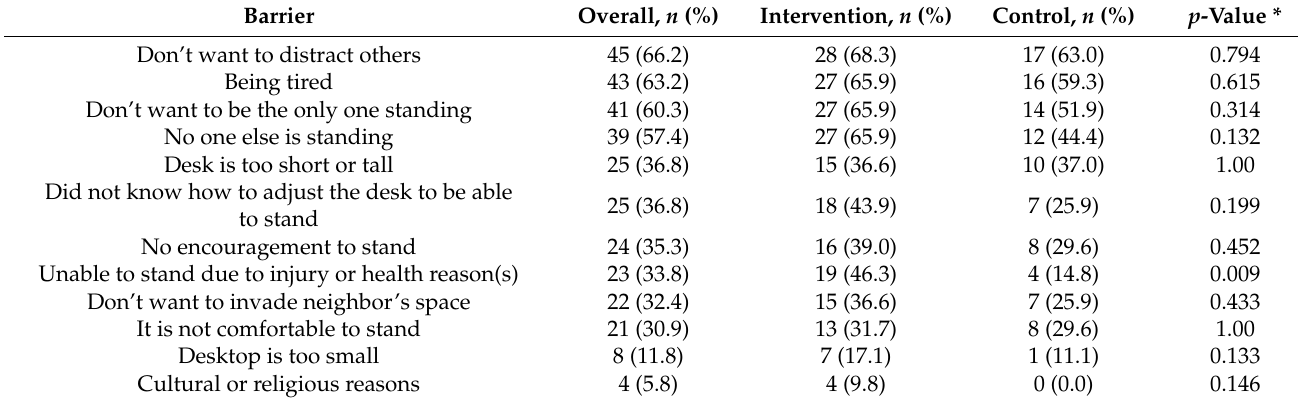
Table 4. Barriers to standing from most to least frequently reported by college students, including differences between intervention and control